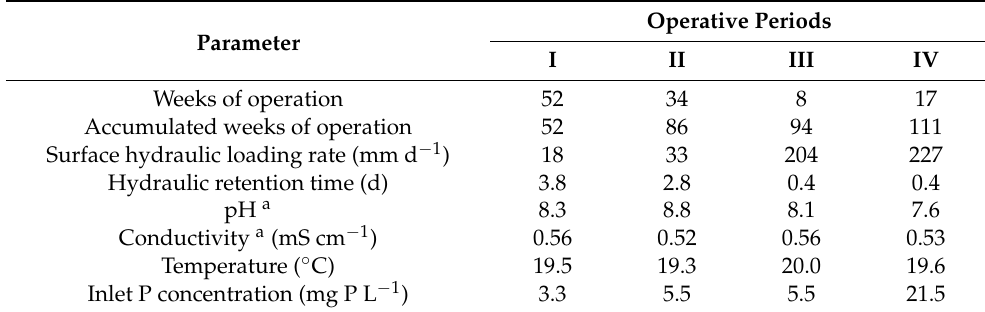
Table 2. Characteristics of the P-spiked tap water for the four operative periods. Operative Periods Parameter I II III IV Weeks of operation 52 17 Accumulated weeks of operation